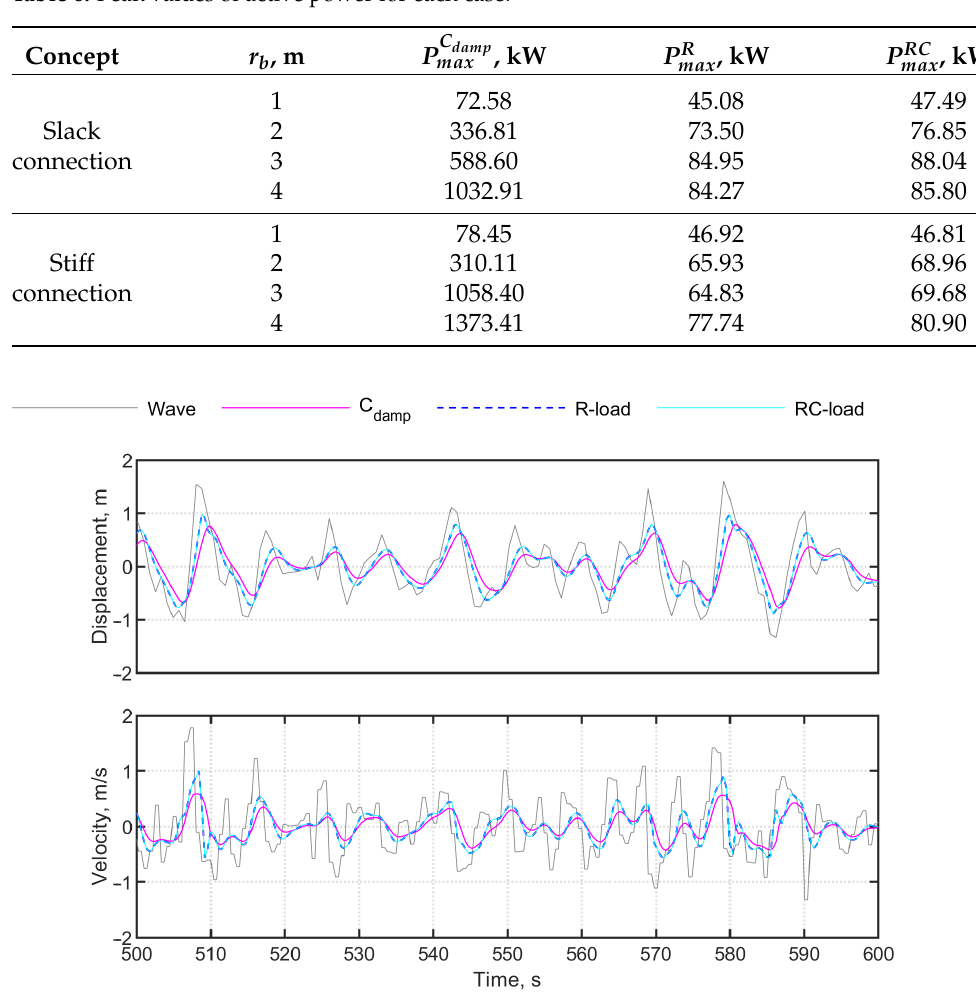
Figure 14. Translator dynamics relative to the wave elevation for the stiff connection. The damping force is calculated by different approaches for the buoy with a radius of 1